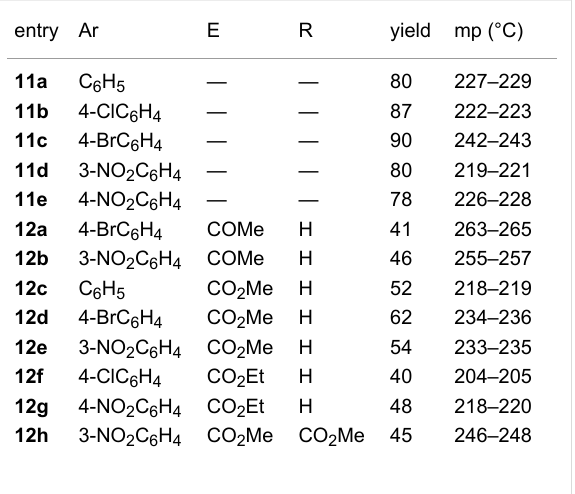
Table 1: The bromides 11 and the new pyrrolo[1,2- c ]pyrimidines 12